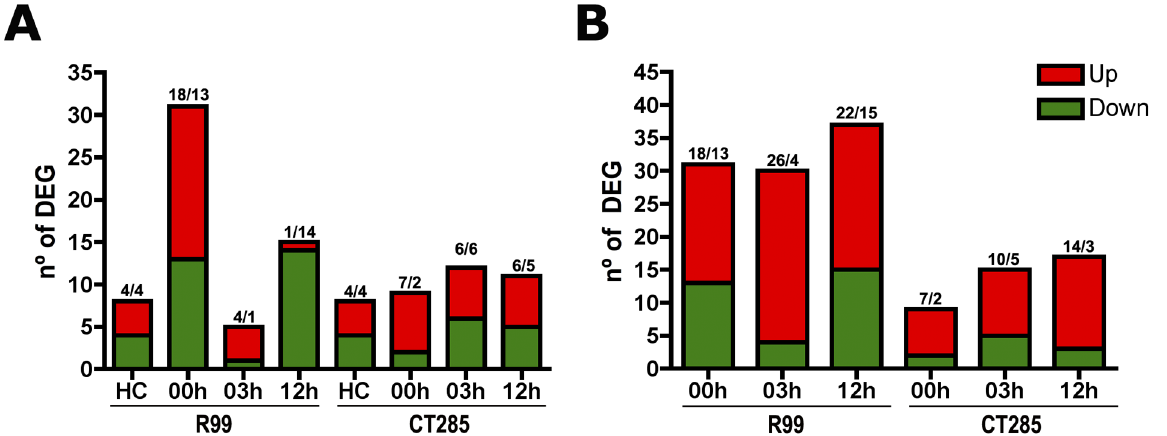
Fig 2. Magnitude of response by mean representation of differential expressed genes (DEGs). Bars represent the sum of upregulated (in red) and downregulated (in green) DEGs of each sampling group (n = 3). Numbers on the top of each bar represent DEGs number up/downregulated. (A) Loop analysis approach and on (B) Relative analysis against handling control group (HC). Numbers above the columns indicate upregulated/downregulated